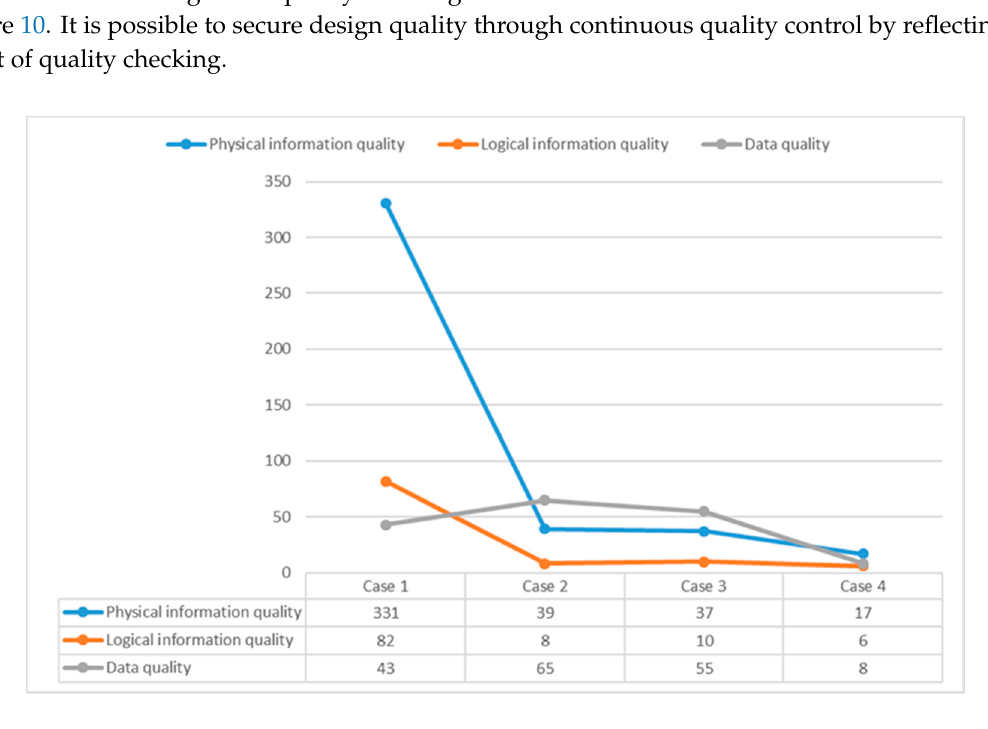
Figure 10. The comparison of achievement according to the quality checking results.